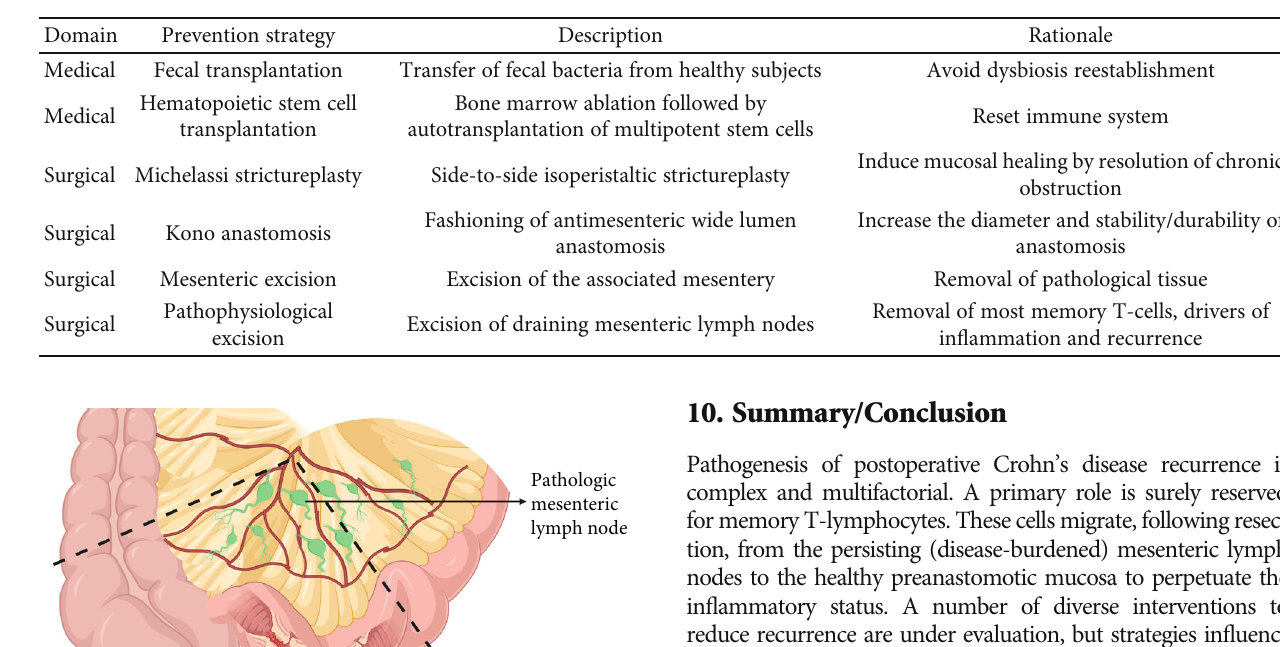
Table 2: New perspectives for recurrence prevention.